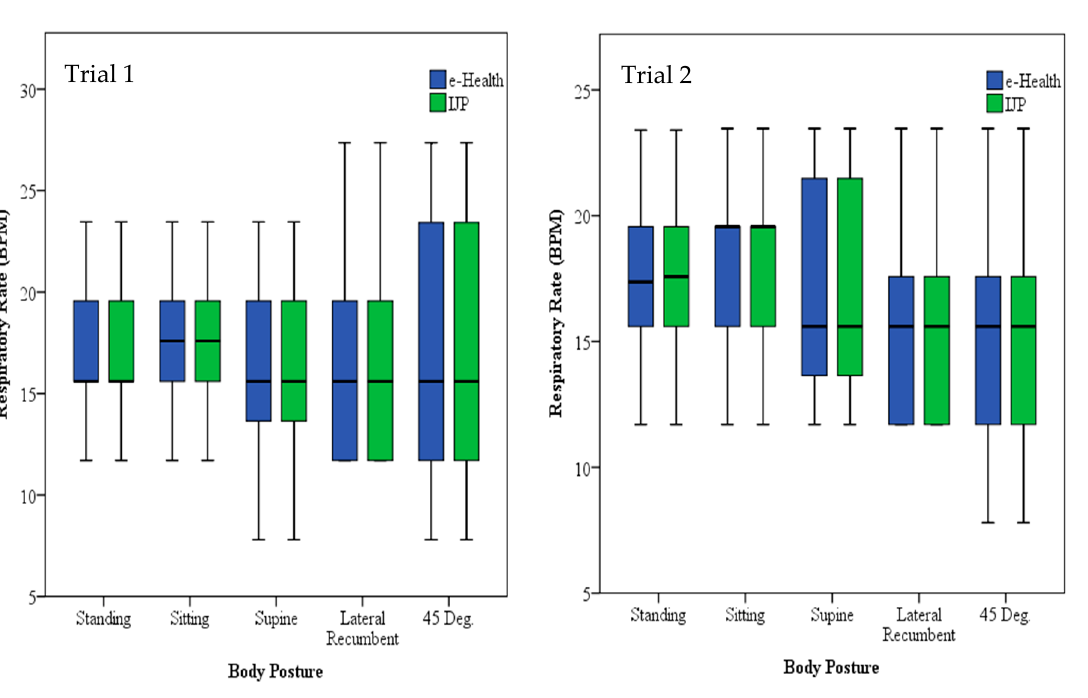
Figure 4. RR derivation flow chart from the IJP sensor. The raw data was input into band-pass filter to filter out the high frequencies and the noise. The RR was then extracted by Simulink (R2018b, MathWorks Inc., Natick, MA, USA). The arrow in the first subfigure shows the spike caused by noise.